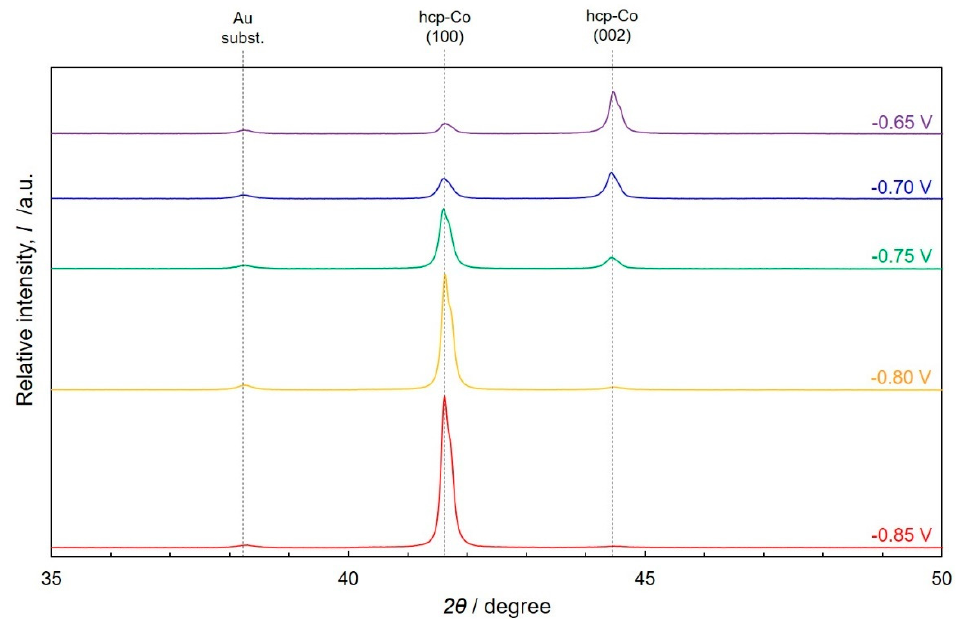
Figure 8. X-ray diffraction (XRD) patterns of Co nanowire arrays that were electrodeposited at cathode potentials of − 0.65 V, − 0.70 V, − 0.75 V, − 0.80 V, and − 0.85 V.